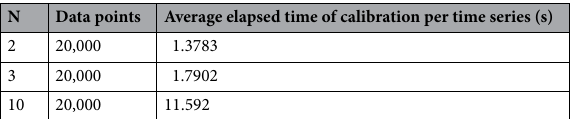
Table 1. The average elapsed time of calibration from 128 time series.